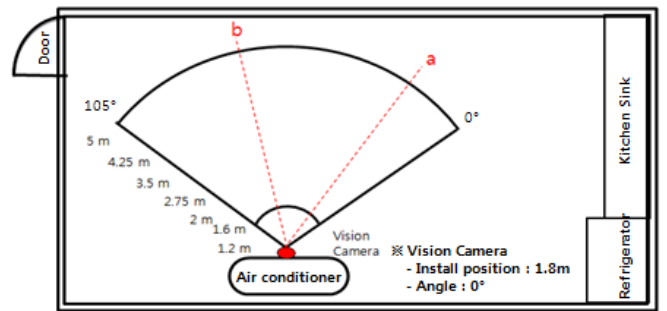
Figure 14. Living area detection experiment—environmental conditions.